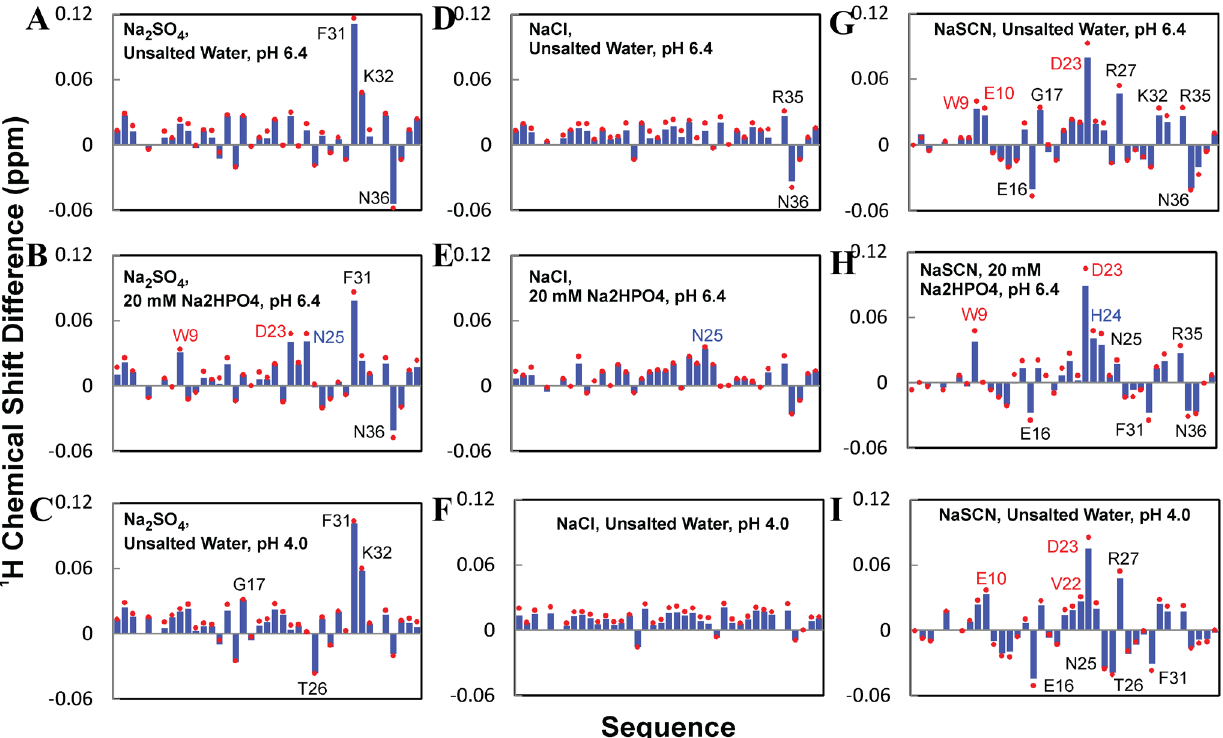
Figure 20. Anion-binding to WW4 as monitored by NMR. Residue-specific chemical shift differences (CSD) of amide protons of the WW4 domain triggered by titration of Na SO , NaCl and NaSCN. ( A )–( C ) Na SO ; (D) – (F) NaCl; and (G) – (I) NaSCN titrations of WW4 in unsalted 2 4 2 4 water at pH 6.4; in 20 mM phosphate buffer at pH 6.4, and in water at pH 4.0 respectively. Residues with significant 1 H chemical shift changes (>0.03 ppm) are labeled: red for residues with amide proton H/D exchange rate (Kex) <5 h -1 and blue for residues with significant changes only in the presence of 20 mM sodium phosphate buffer (pH